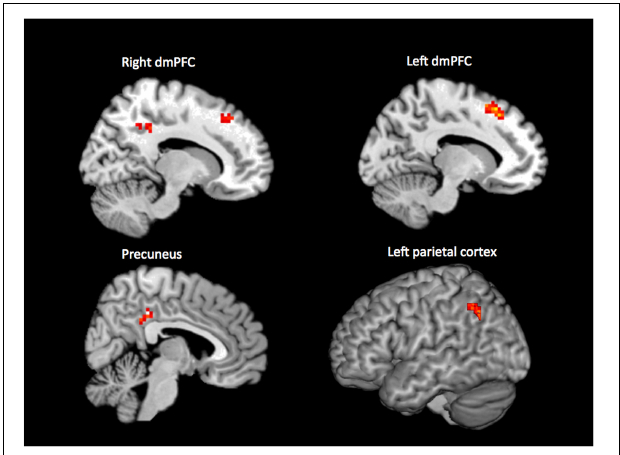
FIGURE 1 | Results of the whole-brain contrast of unanimously classified internal vs. external samples ( p < 0.001, cluster size corrected).